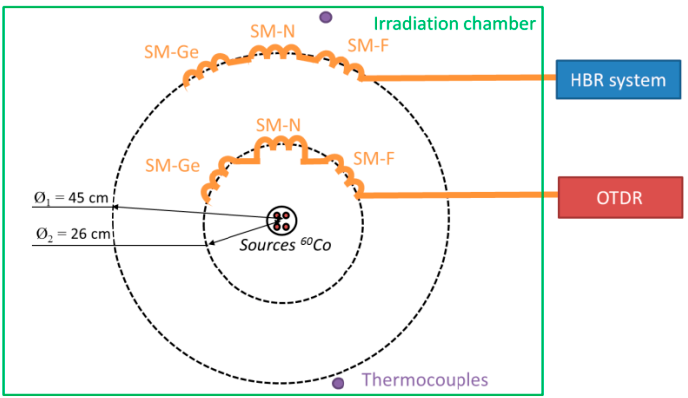
Figure 3. Schematic representation of the on-line experimental setup.